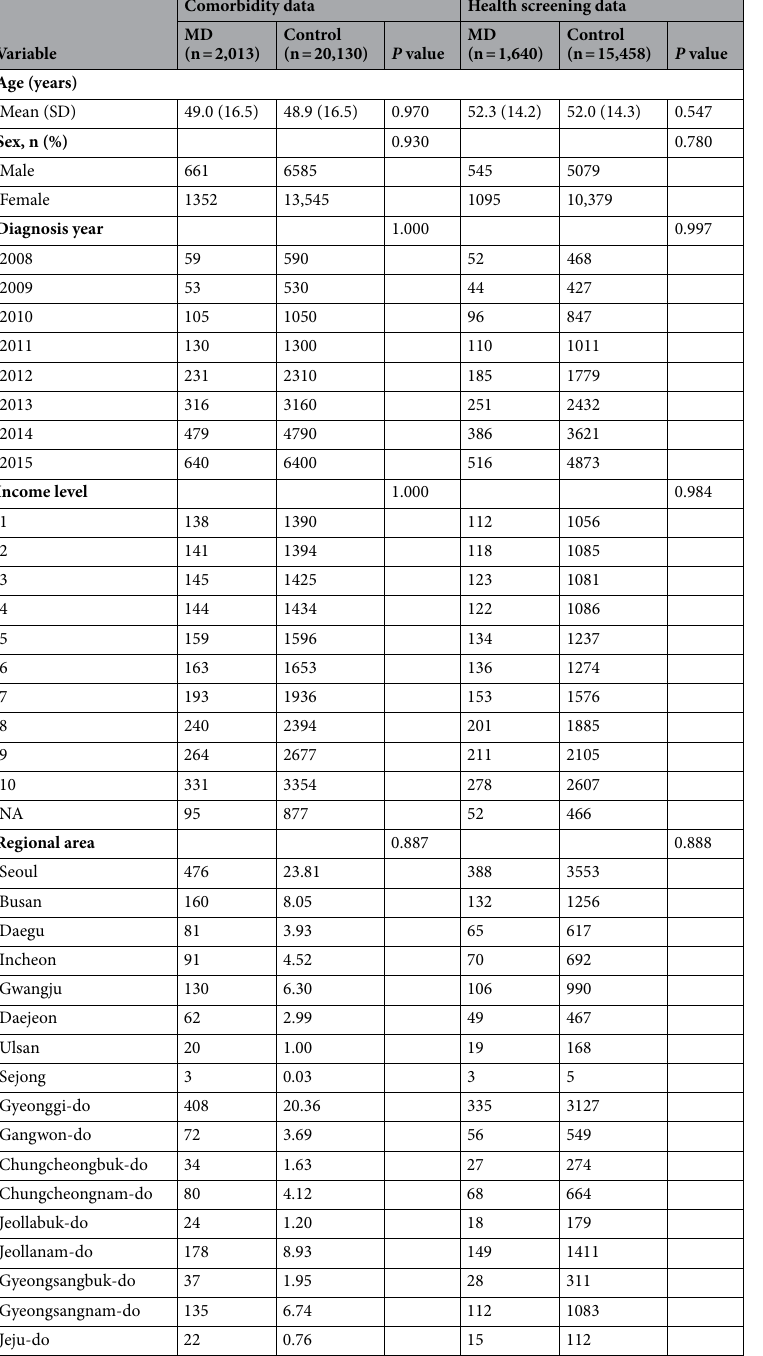
Table 2. Baseline characteristics of participants. MD Ménière